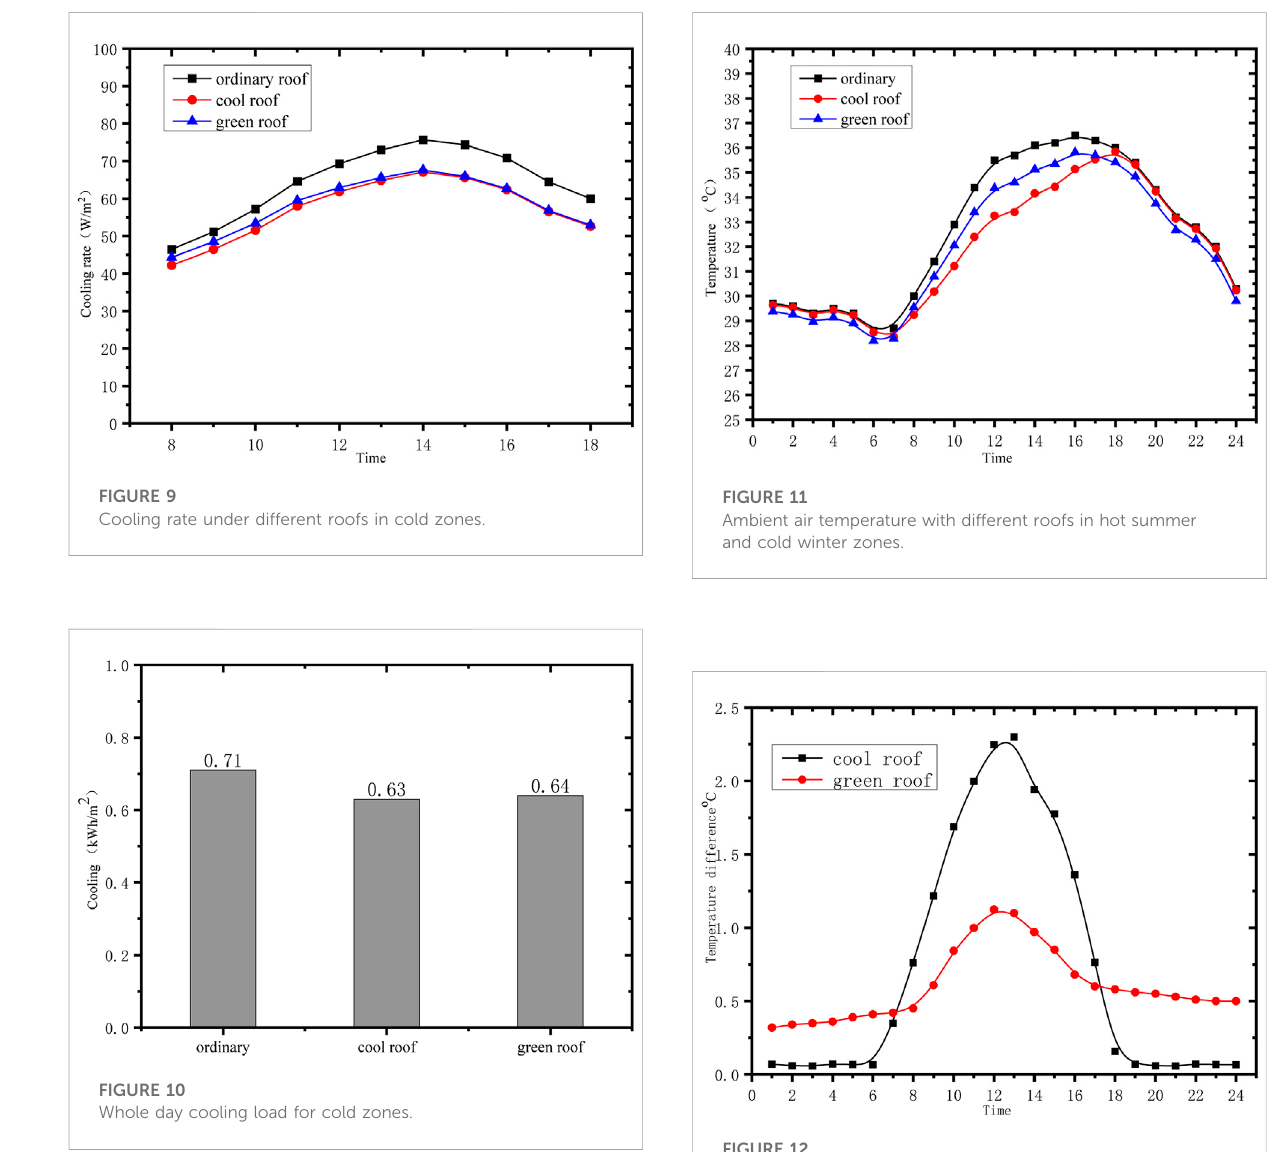
FIGURE 12 Ambient air temperature difference in hot summer and cold winter